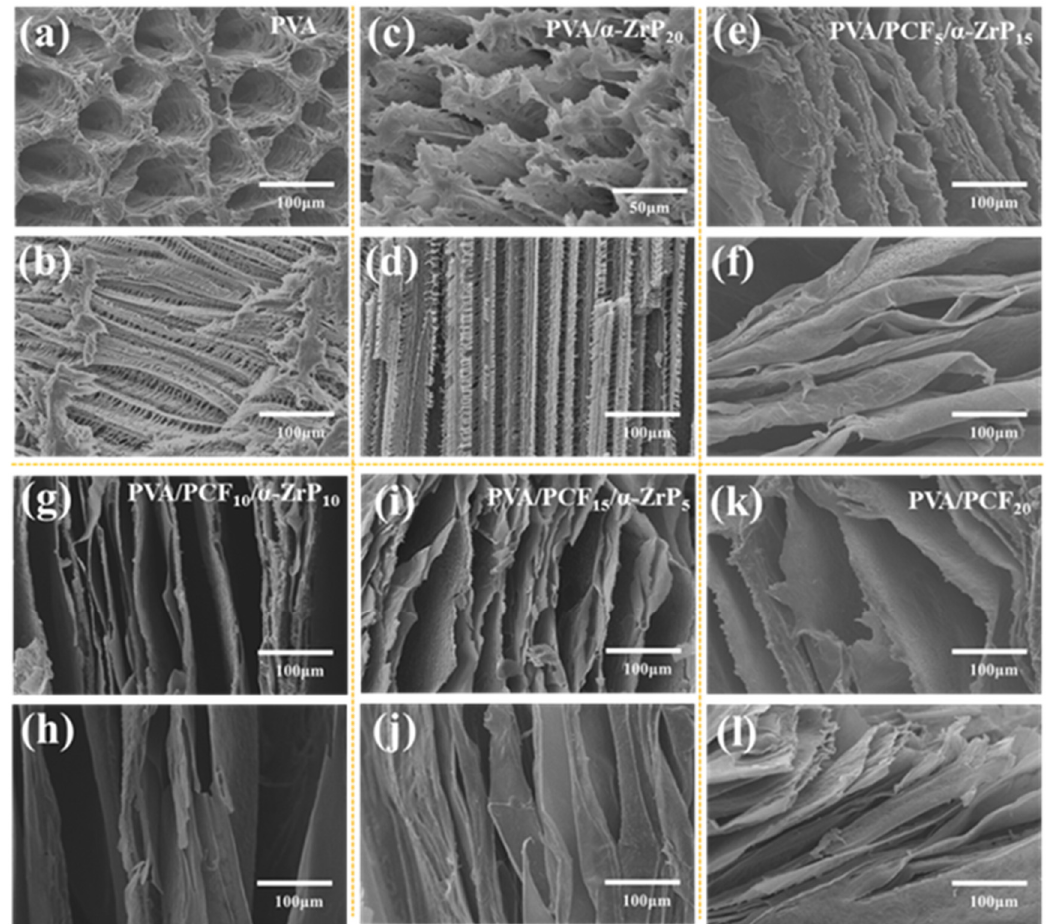
Figure 3. SEM images of the cross sectional and longitudinal sections of PVA/PCF x / α -ZrP y aerogels. ( a , b ): PVA; ( c , d ): PVA/ α -ZrP 20 ; ( e , f ): PVA/PCF 5 / α -ZrP 15 ; ( g , h ): PVA/PCF 10 / α -ZrP 10 ; ( i , j ): PVA/PCF 15 / α -ZrP 5 ; and ( k , l ): PVA/PCF 20 .